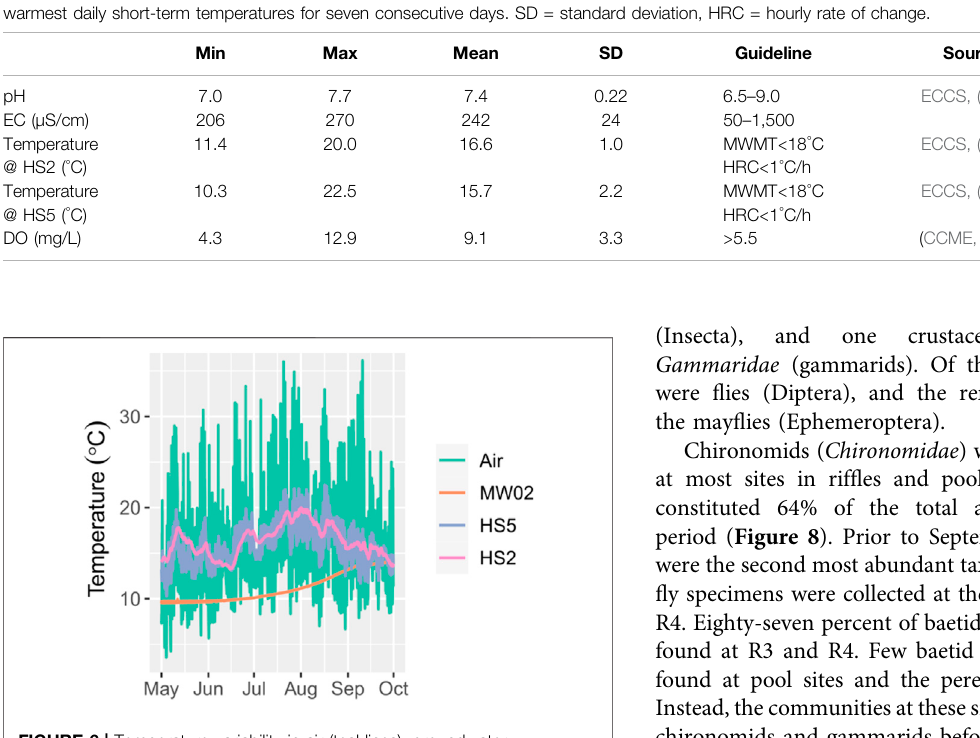
FIGURE 6 | Temperature variability in air (teal lines), groundwater (MW02) (orange line), and the stream in the upstream pool at HS2 (pink) and downstream rif fl e at HS5 (purple).